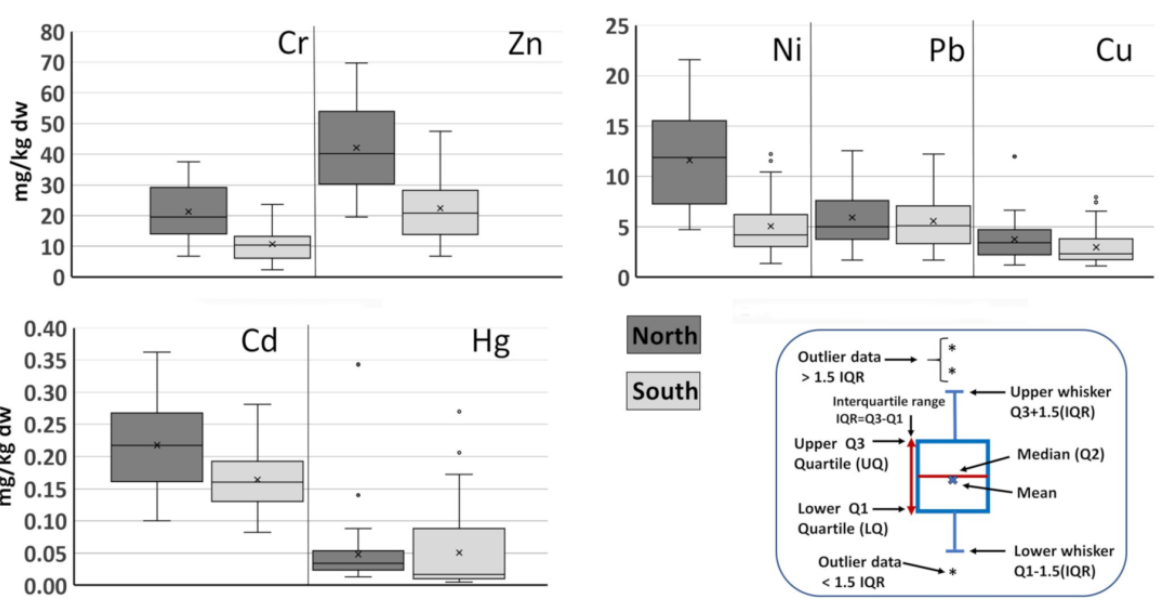
Figure 2. Boxplot of metal content in the sediments of the northern and southern areas of the Valencia coastline.